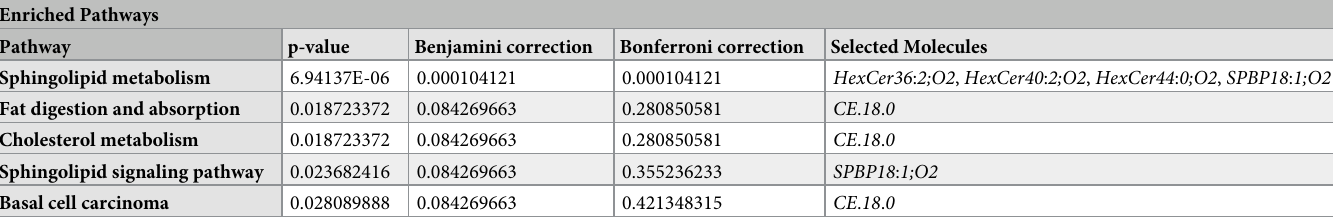
Table 12. Enrichment analysis of lipids associated with COVID-19 severity (all